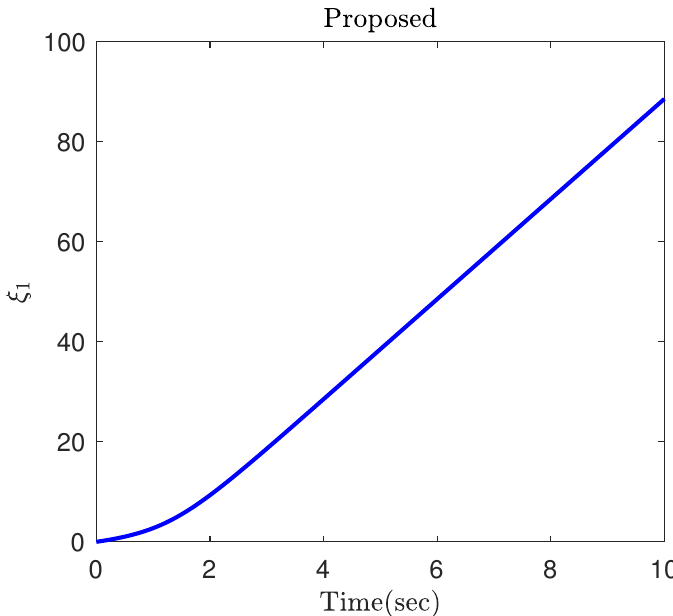
Figure 11. The parameter ξ 1 in Part 2.